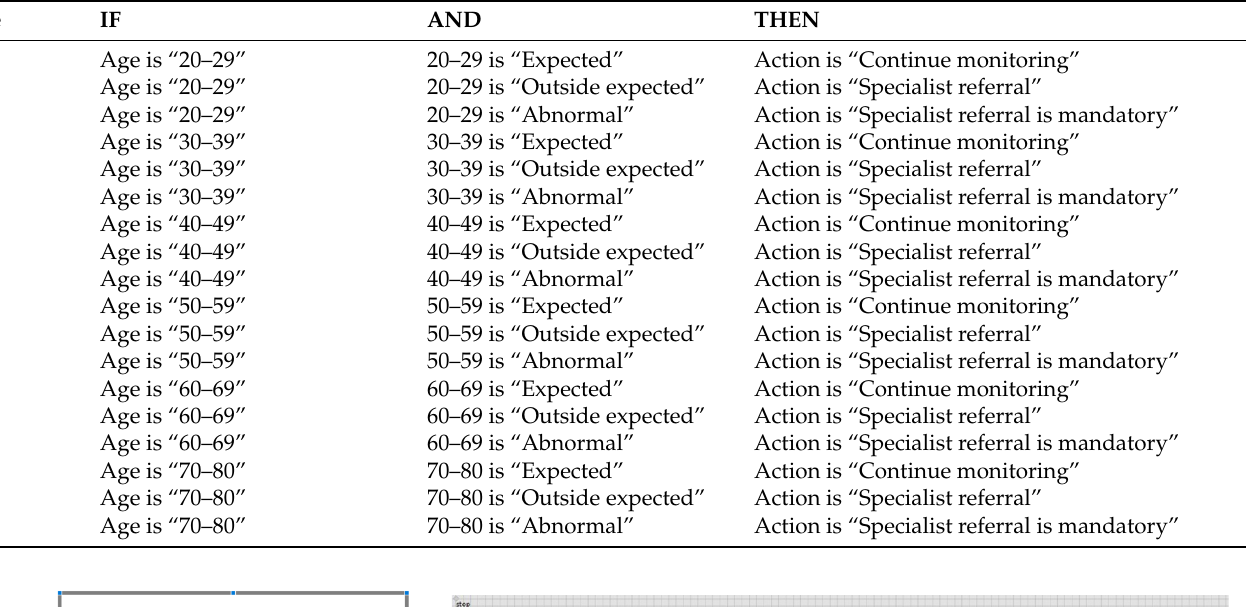
Table 8. Second FL decision system rules.